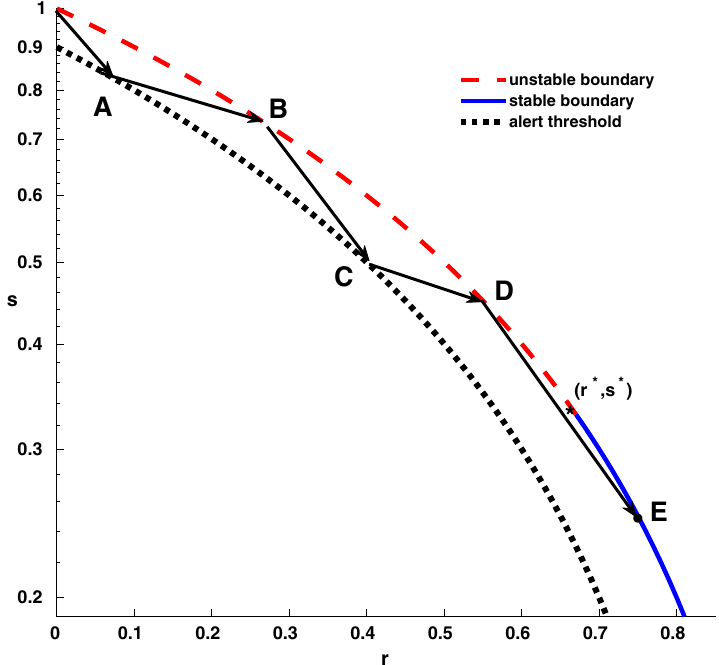
Figure 2. Schematic dynamics of a lockdown strategy for a S ( E ) IR epidemic. Horizontal axis: fraction r of recovered (immune) individuals; vertical axis: fraction s of susceptibles (logarithmic scale). The thick concave curve represents the “end of epidemic” boundary where no infectious individuals are present; the red dashed part of the curve represents unstable points, while the stable boundary is in blue. The black dotted concave curve corresponds to a fraction of 10% of the population being infected. In the picture, we show a simple strategy that contains an epidemic with basic reproduction number R 0 = 3 by lockdowns that reduce the reproduction lock 0.7 whenever the fraction of infectious individuals hits the alert threshold θ = 10% . The number to R 0 = evolution of unconstrained and “locked down” epidemics are represented by straight lines ending with arrows. Lockdowns corresponds to the segments AB and CD ; since, for the parameter chosen, their ending point B , D belong to the unstable boundary (i.e. r < r ∗ ), the epidemic will start again when the lockdown is lifted. The process of unconstrained epidemics and lockdown interventions repeats again until a final point beyond herd immunity is reached. For the chosen parameters, the epidemic stops when hitting the stable boundary at the point E where the fraction of recovered individuals is r E = 76% of the population, less than the size r ∞ = 94% of the unconstrained epidemic (see Fig. 1), but still higher than the herd immunity threshold r ∗ = 67% . Again, vaccination—if available—is a better